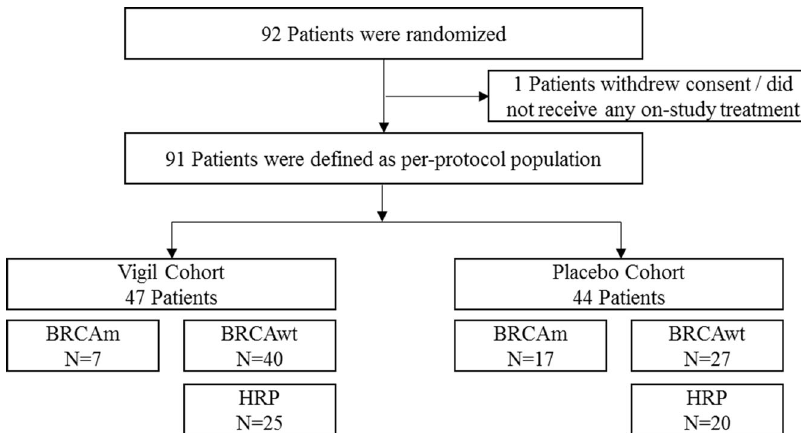
Fig. 1 CONSORT Diagram. Flow of patients through the VITAL trial.